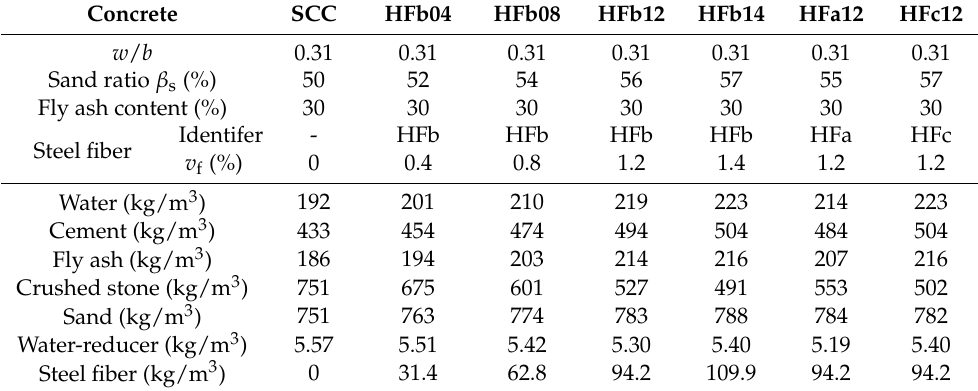
Table 1. Detailed mix proportion of self-compacting (steel fiber reinforced concrete) SFRC and reference (self-compacting concrete)